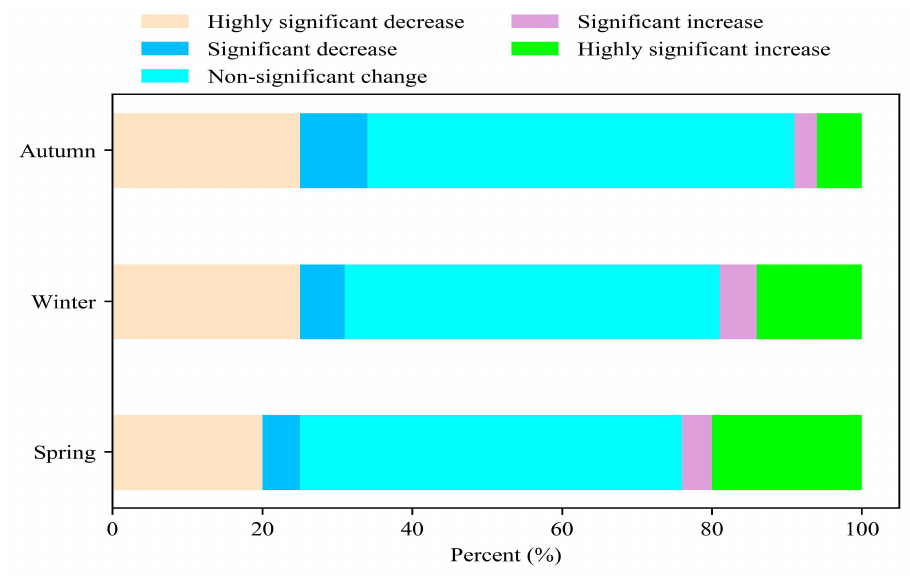
Figure 7. The statistical analysis of the variation trend grades for the seasonal maximum snow depth in three snow cover seasons, namely, autumn (September to November), winter (December to February), and spring (March to June), from 1992–2016.